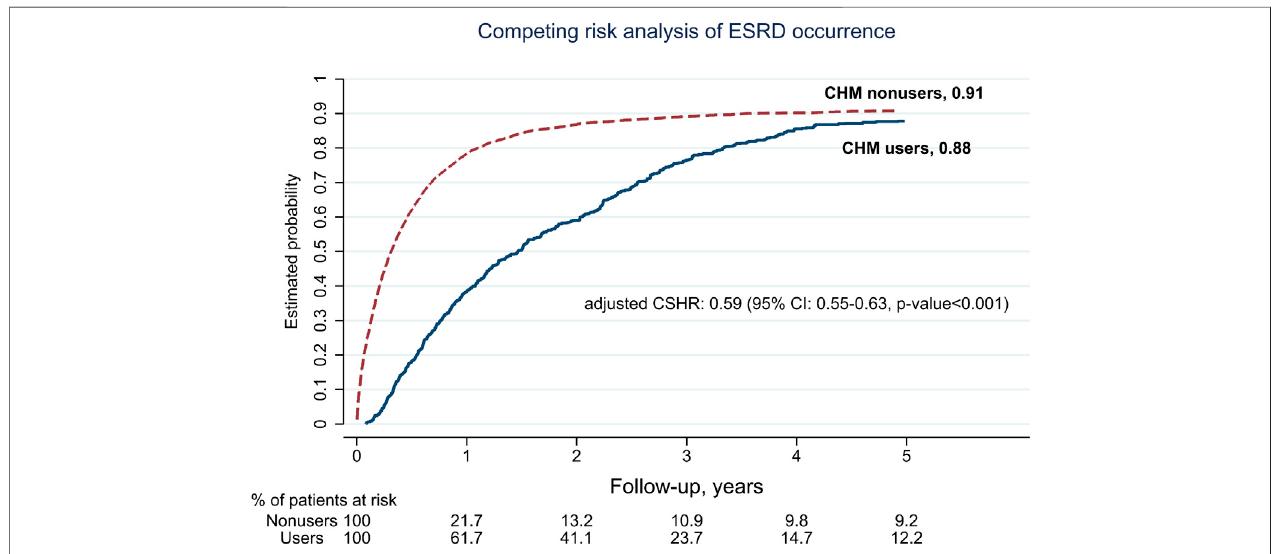
FIGURE 3 | 5-year follow-up for the occurrence of end-stage of renal disease (ESRD) among pre-dialysis diabetic nephropathy (DN) patients by using competing risk analysis after balancing covariates with overlap weighting (Abbreviations: CSHR, cause-speci fi c hazard ratio; CI, con fi dence interval).